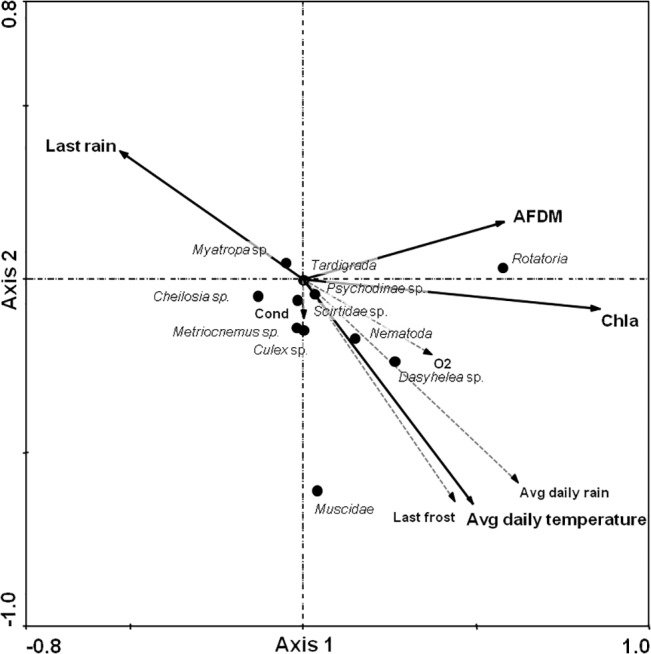
Redundancy analysis biplot of the 12 identified taxa and eight relevant environmental factors.Significant predictors of the organism density distribution are shown in bold (Monte Carlo permutation test, p < 0.05). Abbreviations: Last rain = number of days after the last rain; Last frost = number of days after the last frost; Chla = chlorophyll a; Cond = conductivity. Sum of all canonical eigenvalues: 0.237 (axis 1: 0.208; axis 2: 0.021).